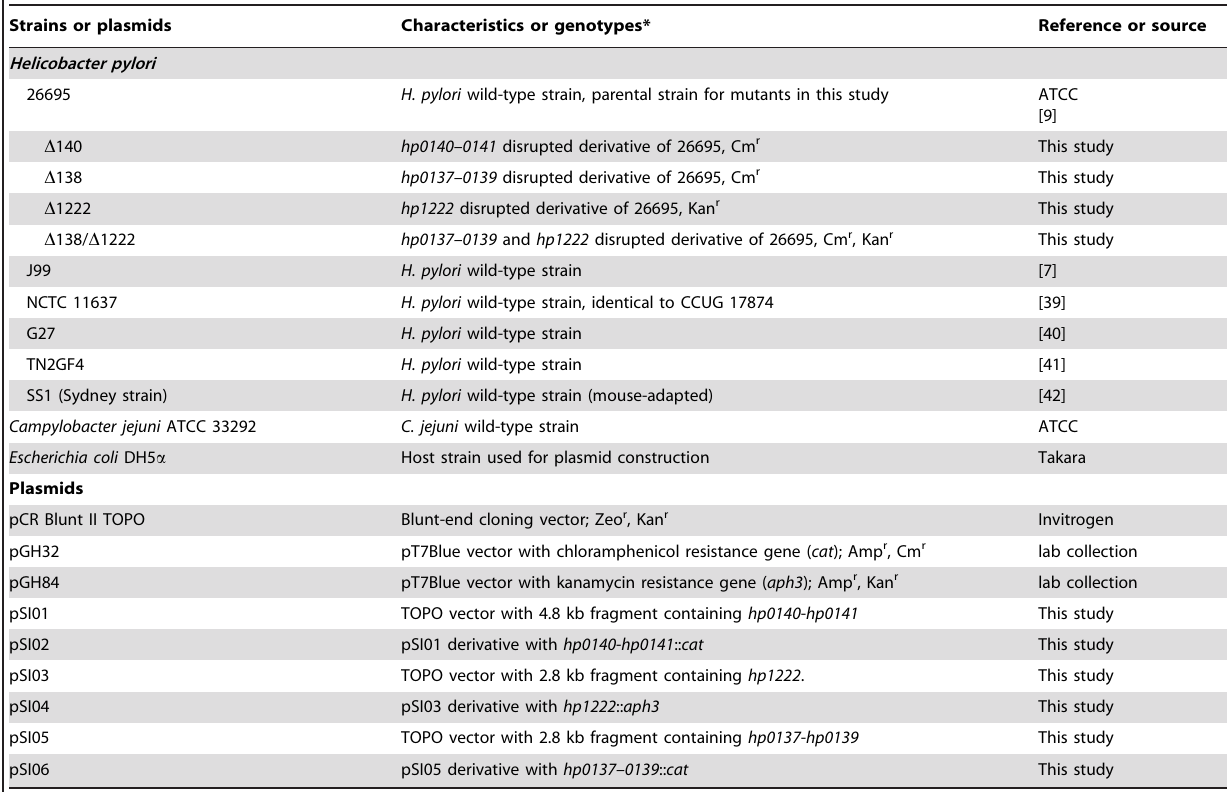
Strains or plasmids Characteristics or